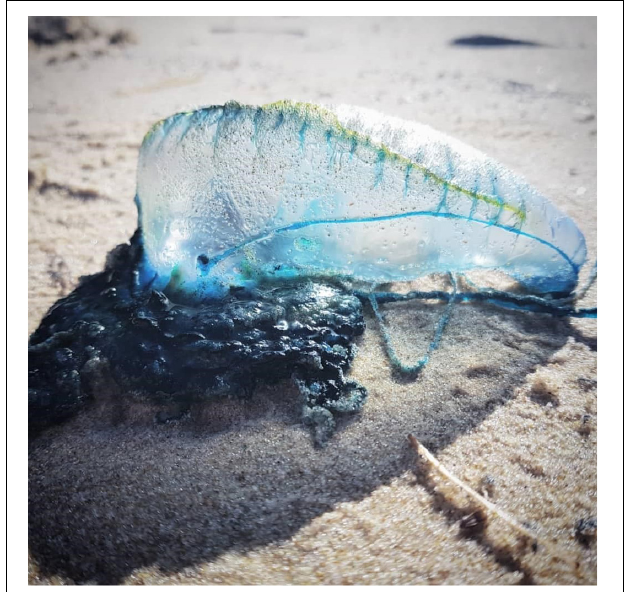
FIGURE 4 | The colony of P. physalis recorded in the north-western coast of Sicily, southern Tyrrhenian basin in 2021 (photo by Rosario